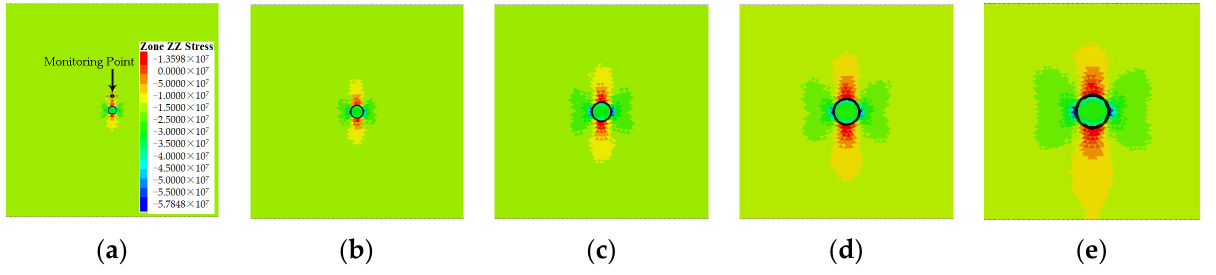
Figure 7. Vertical stress nephogram of different borehole diameters. ( a ) 6 mm; ( b ) 10 mm; ( c ) 15 mm; ( d ) 20 mm; and ( e ) 25 mm.